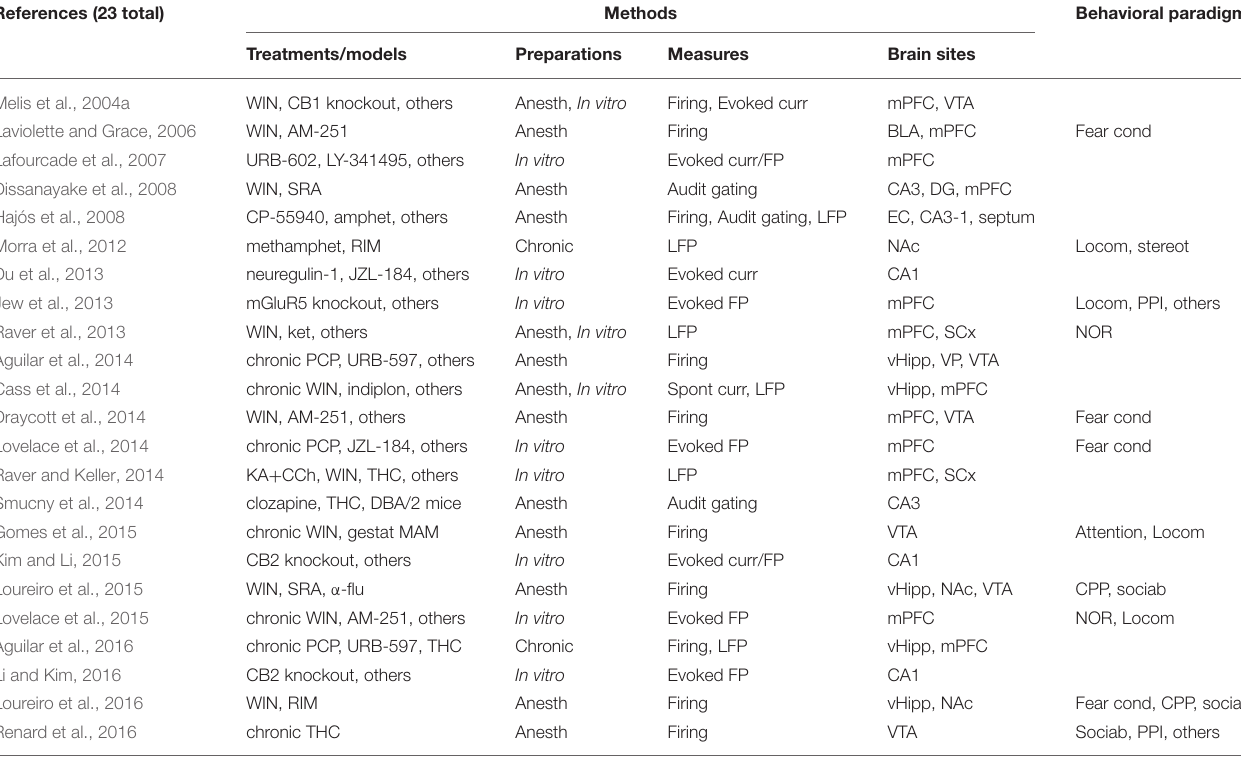
TABLE 1 | Rodent electrophysiology studies involving the eCB system and schizophrenia-relevant